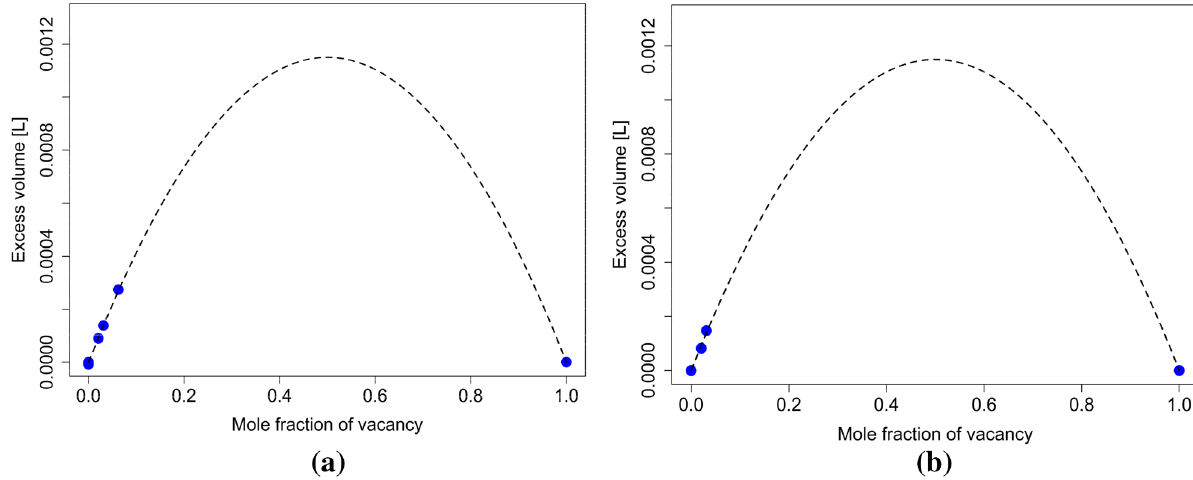
Figure 5. ( a ) Excess volume for FCC-Cu ( b ) excess volume for